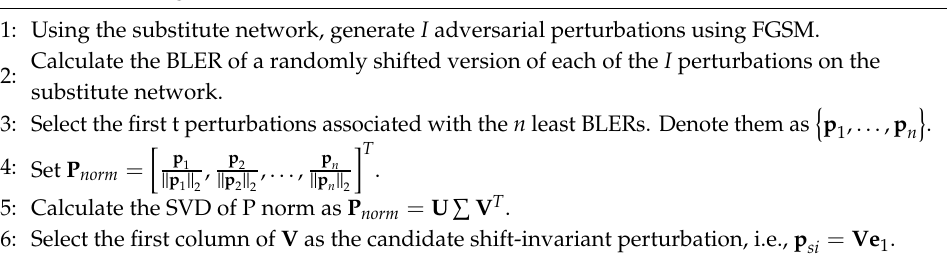
Algorithm 1 Design Shift-Invariant Perturbations